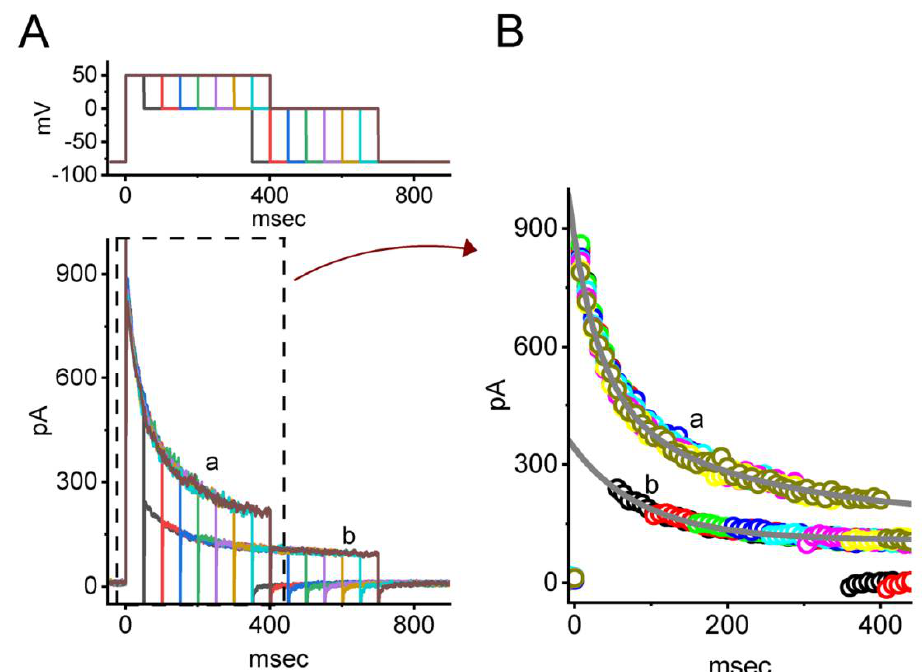
Figure 5. Effect of VOR on I K(DR) evoked by the depolarizing pulse with varying durations. These experiments were conducted in cells held at the level of − 50 mV, and the depolarizing command voltages from − 50 to +50 mV with different durations of test pulse (50–400 ms in 50-ms increments) followed by a return to 0 mV for 300 ms were applied to the examined cell. In ( A ), current traces labeled a were obtained at the level of +50 mV with varying duration during cell exposure to 10 µ M VOR, while the traces labeled b were at the level of 0 mV. The voltage-clamp protocol applied is illustrated in the upper part. In ( B ), current traces indicate an expanded record (dashed box) in (A). The time constants obtained at the level of +50 mV (a) by fitting to two exponential function was well estimated to be 211 and 37.9 ms, while that at 0 mV (b) by fitting to single exponential was 92.5 ms.